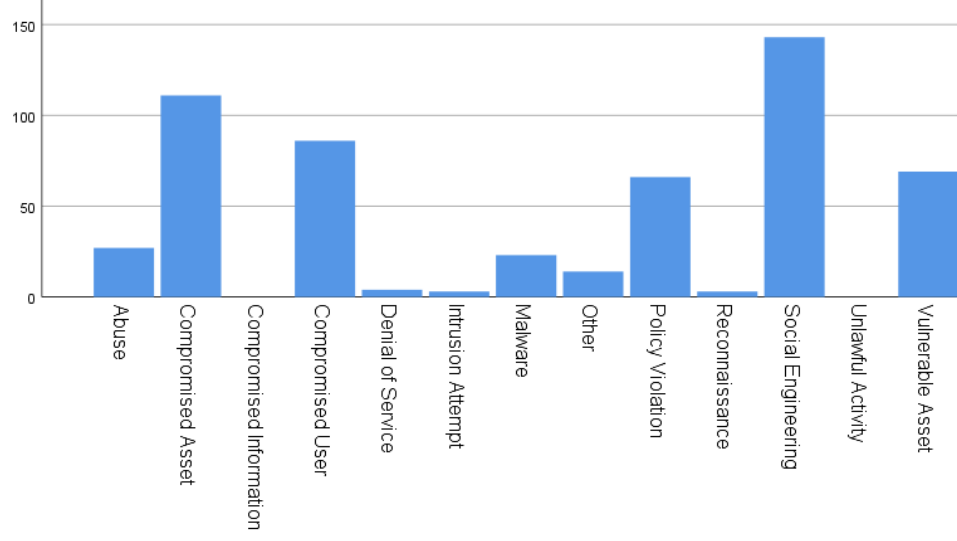
Figure 2. Incident causes in the Norwegian University SOC, histogram from Wangen